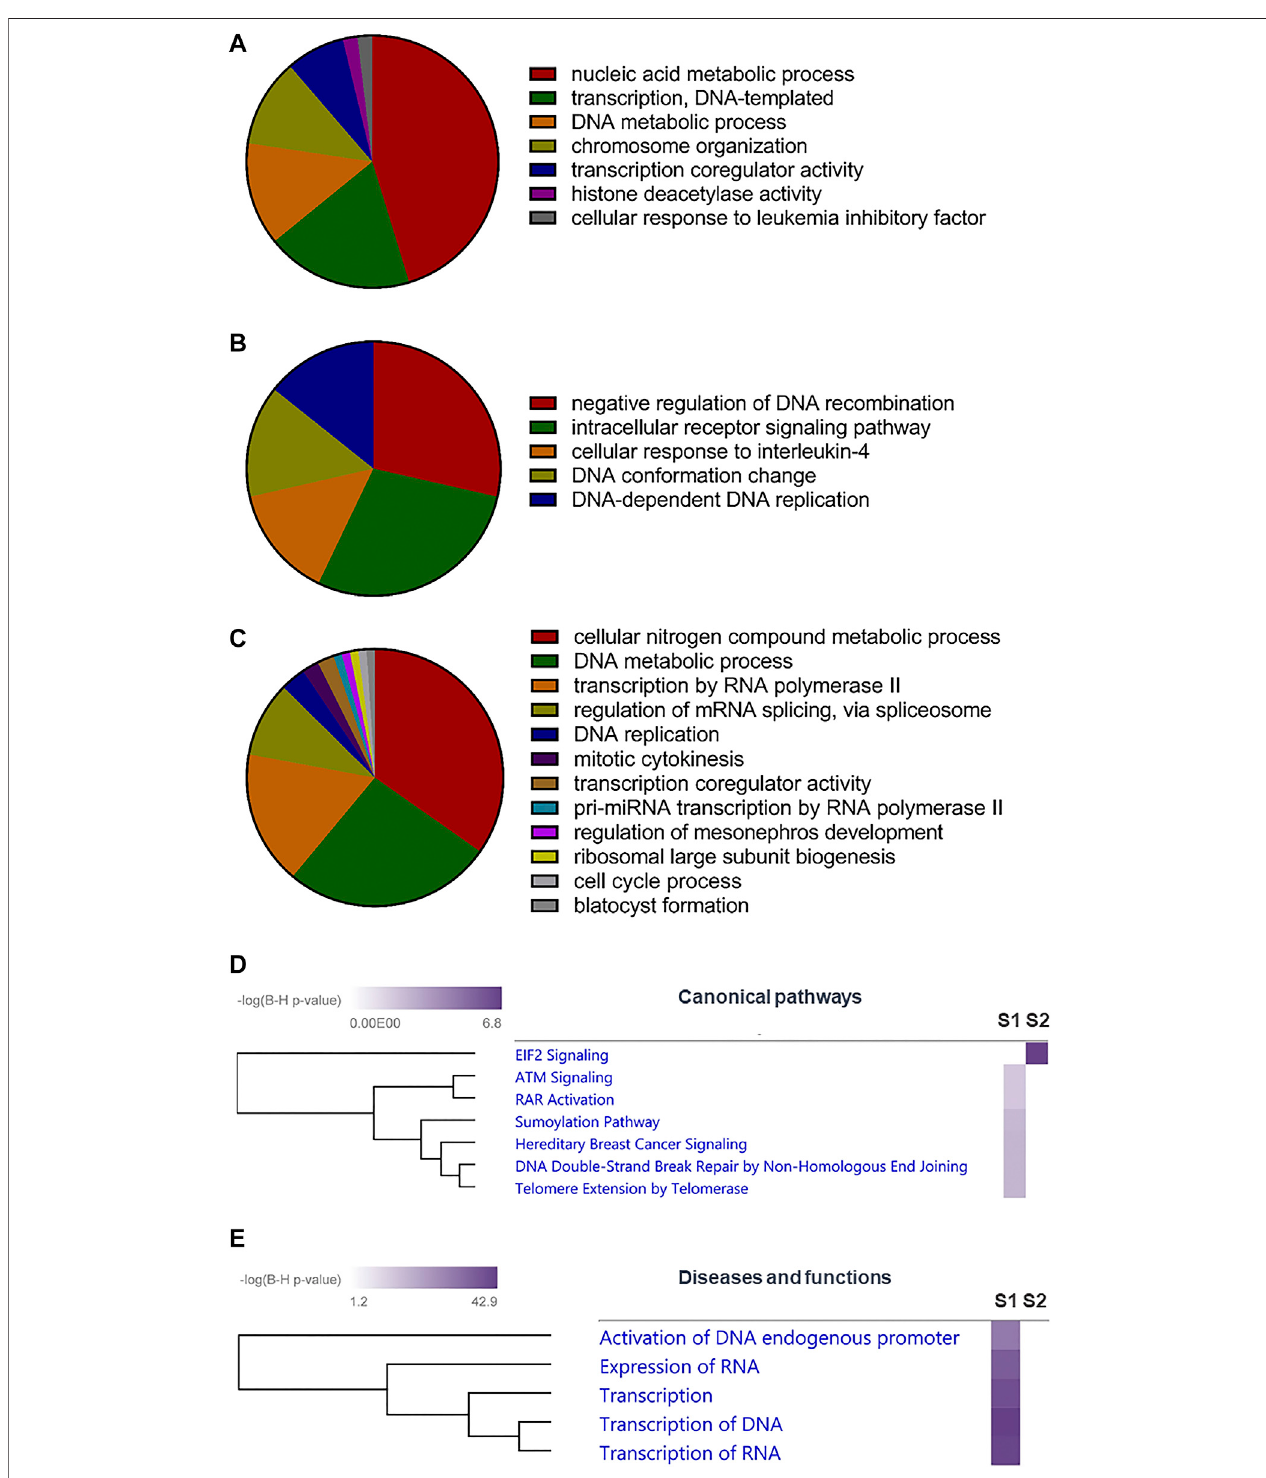
FIGURE 3 | Role of SUMOylation in mpkDCT cells. (A) Gene ontology (GO) analysis by ClueGO for SUMO1 and (B) SUMO2 exclusive proteins, as well as (C) proteinsmodi fi edbybothSUMO1andSUMO2inmpkDCTcells.GOanalysishighlightedthedifferentrolesofSUMO1andSUMO2. (D) IngenuityPathwayAnalysis(IPA) canonical pathway analysis of SUMO1 and SUMO2 exclusive proteins highlighted the high degree of involvement of SUMO2 in Eukaryotic Initiation Factor 2 (EIF2) signalling pathway. (E) IPA diseases and functions analysis reaf fi rmed the importance of SUMOylation in gene transcription.